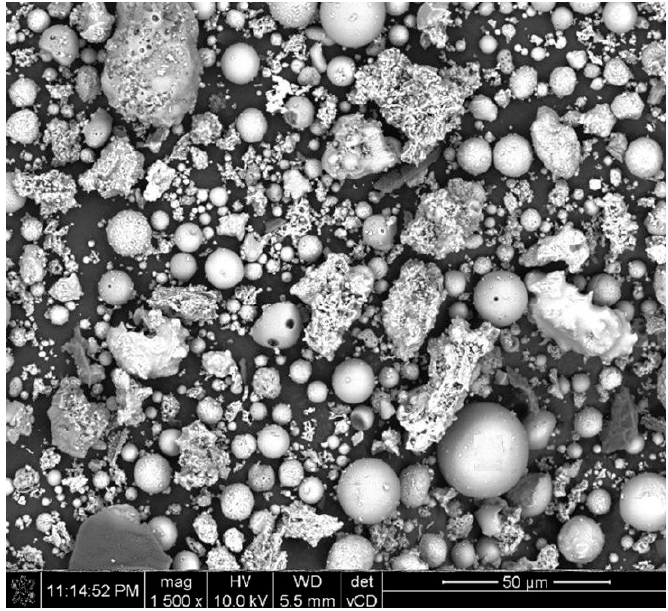
Figure 6. Morphology of calcareous fly ash grains batch A (magnification of 1500 times).